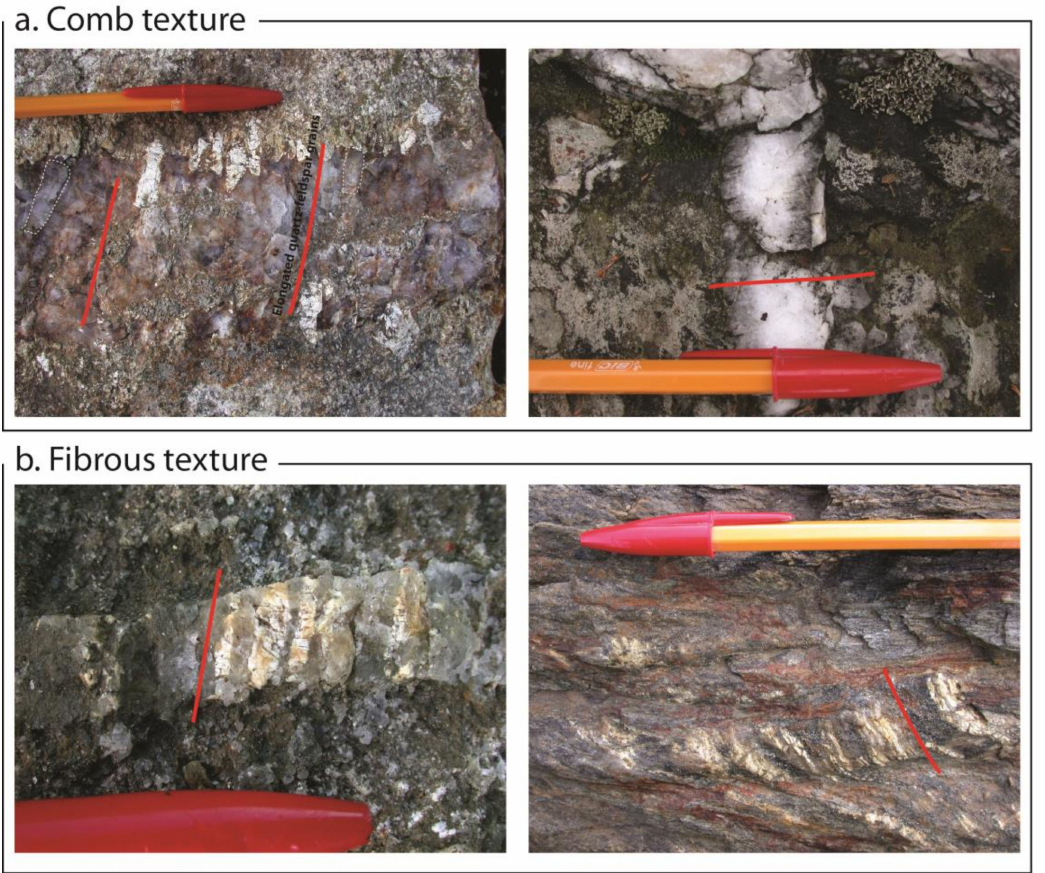
Figure 3. Examples of comb and fibrous textures from the Hercynian mining district of Tras-os-Montes, Galicia, Spain. Red lines illustrate the elongated quartz and feldspar grains indicate the opening direction. Note the difference between fibres that cross-cut the veins and comb grains that do not traverse the